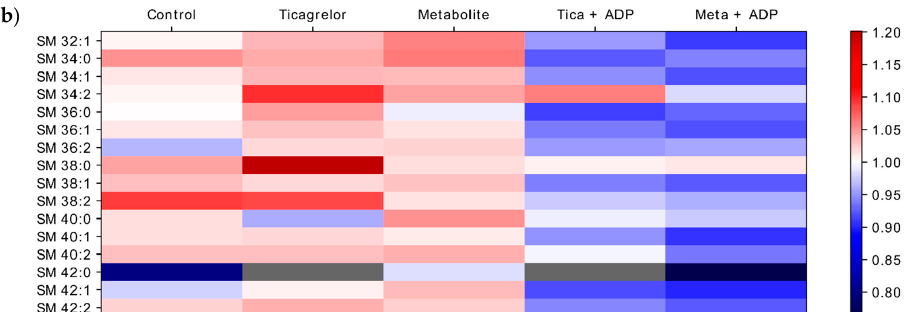
Figure 6. Heatmap representing fold change in ( a ) Phosphatidylcholines (PC) or ( b ) Sphingomyelins (SM) subspecies compared to the ADP group, according the experimental groups. When platelets were pre-treated by ticagrelor or its active metabolite, stimulation by ADP did not lead to an SM or PC composition similar to ADP-isolated stimulation but led to an increase in PC and a decrease in SM fold change compared to the ADP group.